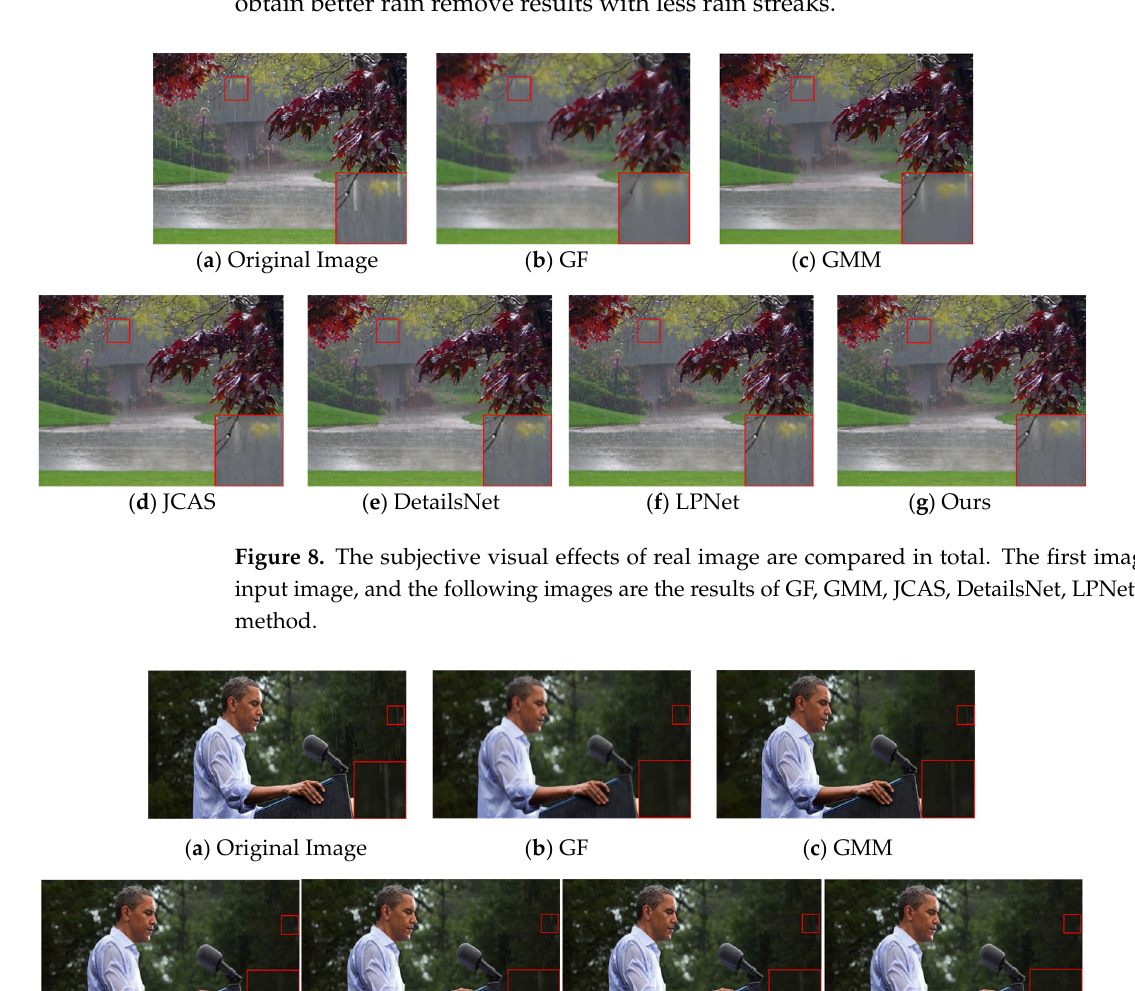
( h ) Ours Figure 7 . The subjective visual effects of the synthetic image (“bamboo”) are compared in total. The first image is the synthetic rain image, the second image is the ground truth, and the following images are the results of GF, GMM, JCAS, DetailsNet, LPNet, and our method. 4.5. Experiments on Real Rainy Images To verify the effectiveness of the proposed method in removing rain layers from real rain images, we tested various comparison methods for real rain images, and randomly selected two images to display the experimental results, as shown in Figures 8 and 9. To better observe the results of the rain removal results, we select a small area in the image to enlarge to compare the details of the image. It can be seen from Figures 8 and 9 that the